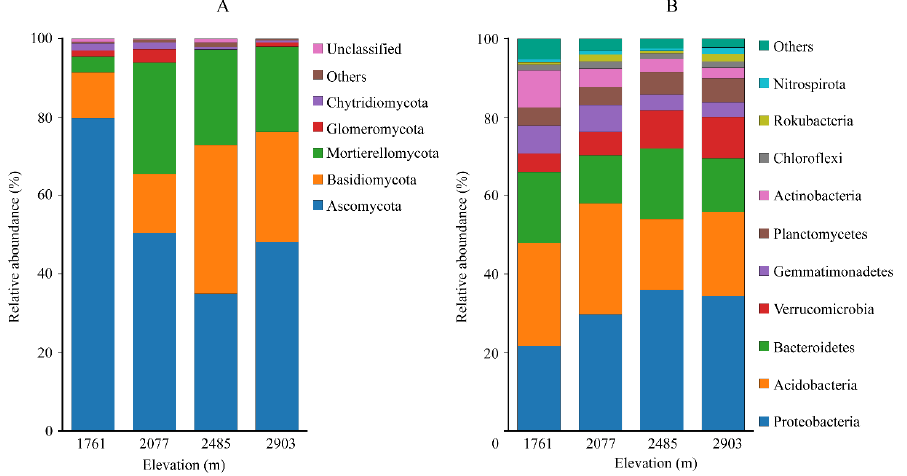
Figure 3. The relative abundance of fungal ( A ) and bacterial ( B ) phyla present in soil at different elevations corresponding to four vegetation types.